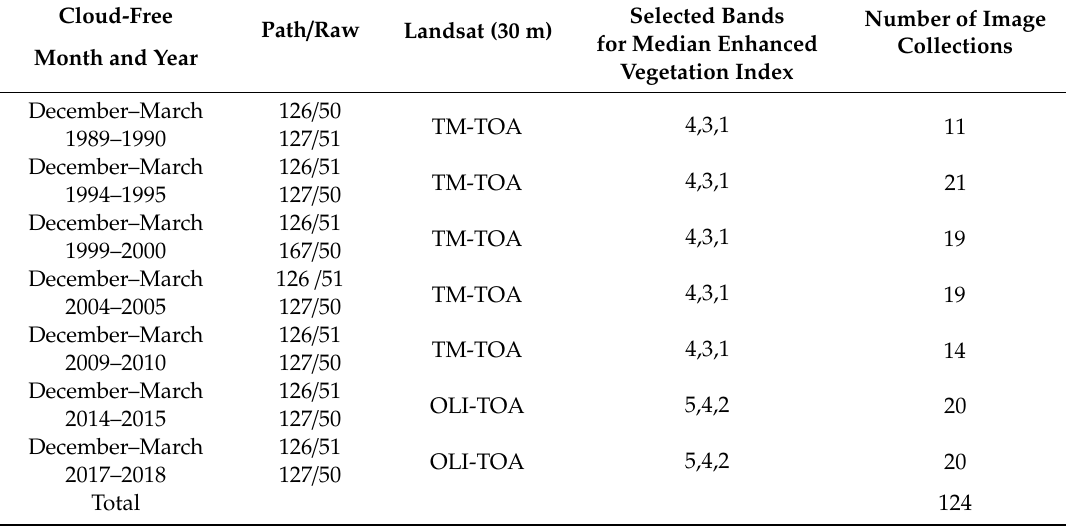
Table 1. Google Earth Engine Landsat collections for the phenology-based threshold classification method (PBTC) and the assessment of carbon stock changes in Siem Reap province over 28